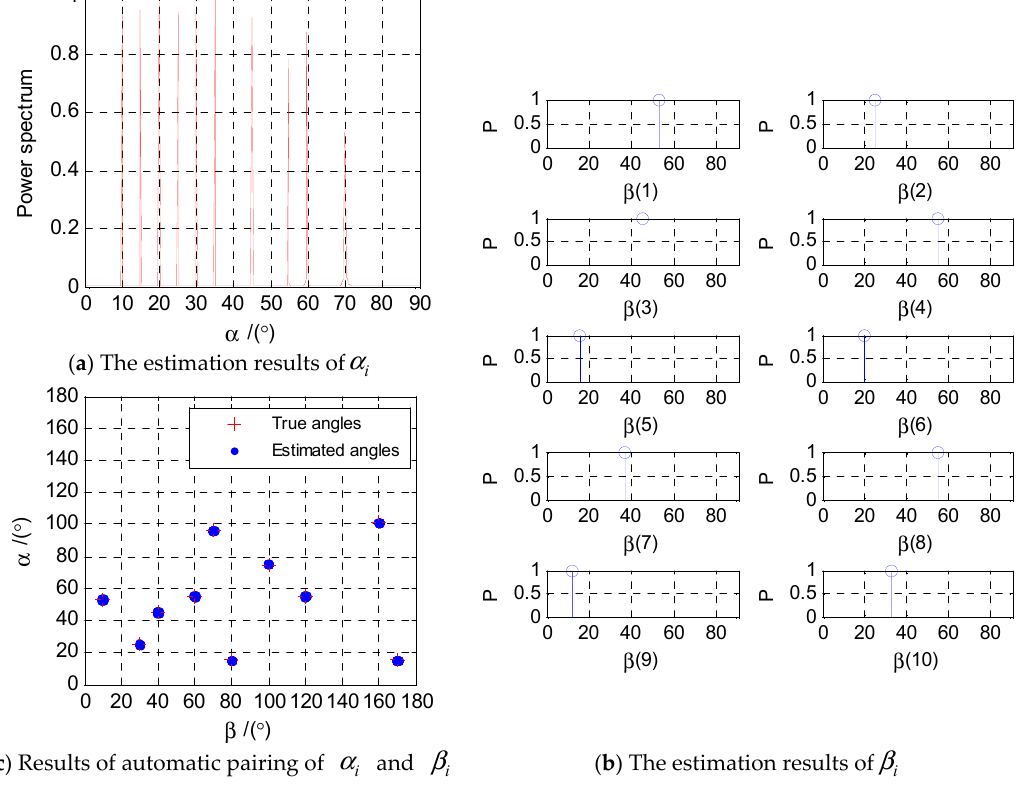
Figure 4. 2-D DOA estimation results. Algorithm 1. The proposed algorithm steps for the 2-D angle estimation of parallel nested array.